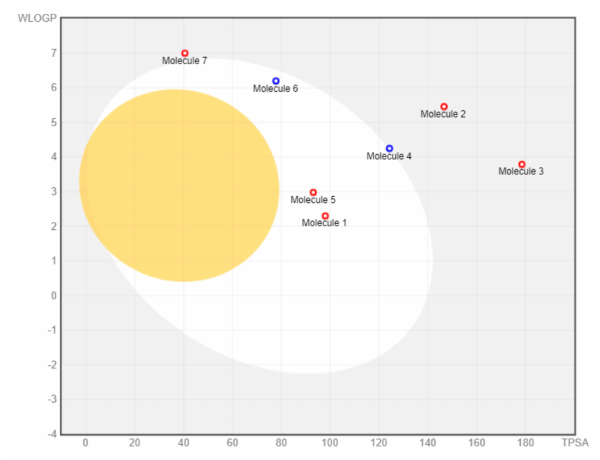
Figure 9. BOILED-Egg visualization. Compared to M. pendans compounds, quercetin and curcumin (as the control positive) meet Lipinski’s rule. Quercetin is not absorbed by the brain (BBB), but is absorbed in the human intestines, with a value of 69.799. It also does not cause toxic effects with a value of Caco-2 0.737. Based on the ADME analysis, quercetin will not interrupt the metabolism of the drug, because it does not interfere with cytochrome P450, except for CYP450 1A2 and CYP450 3A4. Conversely, curcumin penetrates the BBB by inhibiting four CYP450 cytochromes (CYP450 1A2, CYP450 2C9, CYP450 2D6, and CYP450 2C19) and human gastrointestinal absorption (HIA). Moreover, it can be toxic